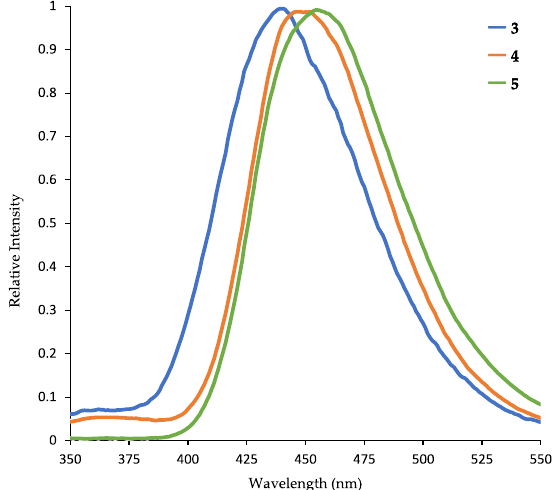
Figure 8. Normalized fluorescence emission spectra of 1-(diphenylamino)naphthalene ( 3 ) (blue), N , N , N ’, N ’-tetraphenylnaphthidine ( 4 ) (orange), and naphthidine 5 (green) in methanol (excitation at λ ex = 291 nm).